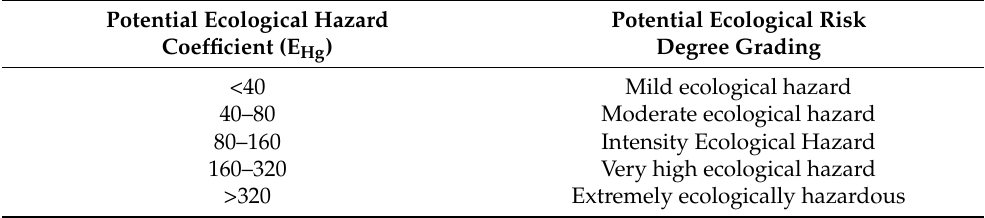
Table 2. Potential ecological risk coefficient and classification of ecological risk